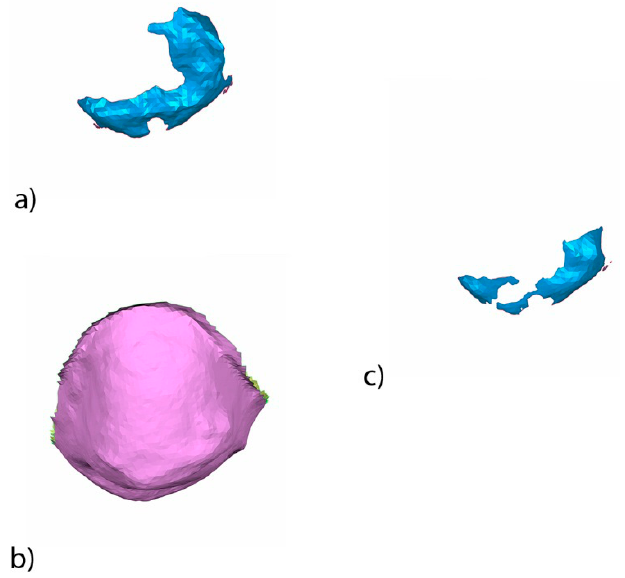
Figure 6. Mesh of the remaining cement after fixed lingual multibracket appliance debonding present in STL3 ( a ), palatal perspective of STL4 ( b ), and mesh of the remaining cement after cement removal in STL4 ( c ).